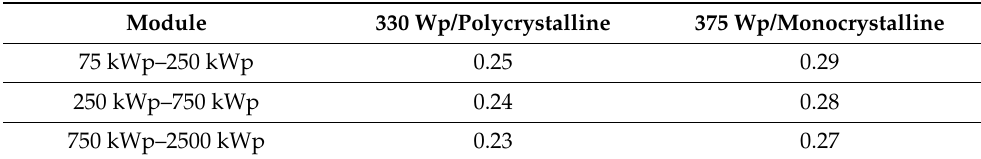
Table 7. Proposed Module cost in € /Wp (year